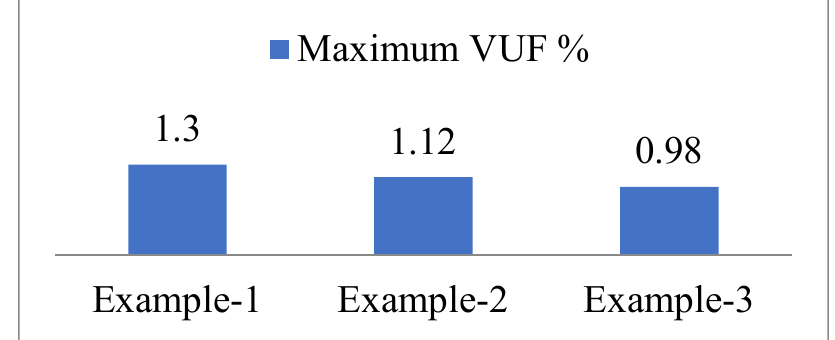
Figure 12. Power loss comparison in different study examples of the IEEE-34 bus URDN.